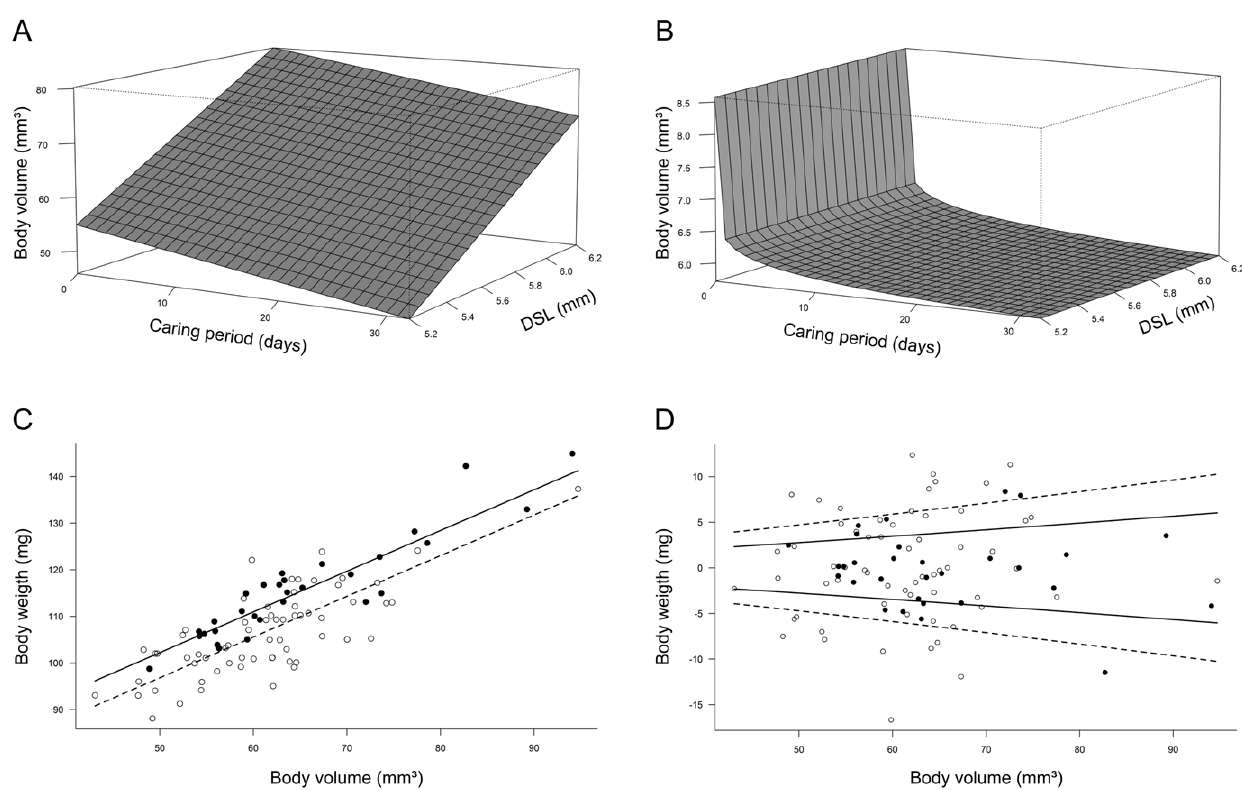
Figure 4. Energetic costs paid by Iporangaia caring males. Effect of caring period on the mean (A) and the variance (B) of males’ body volume controlled by structural body size, i.e., dorsal scute length ( DSL ). Effect of parental state on the mean (C) and the variance (D) of males’ weight controlled by body size, i.e., body volume ( V ). Filled circles and solid lines represent the predicted values for non-caring males, and open circles and dashed lines represent predicted values for caring males.